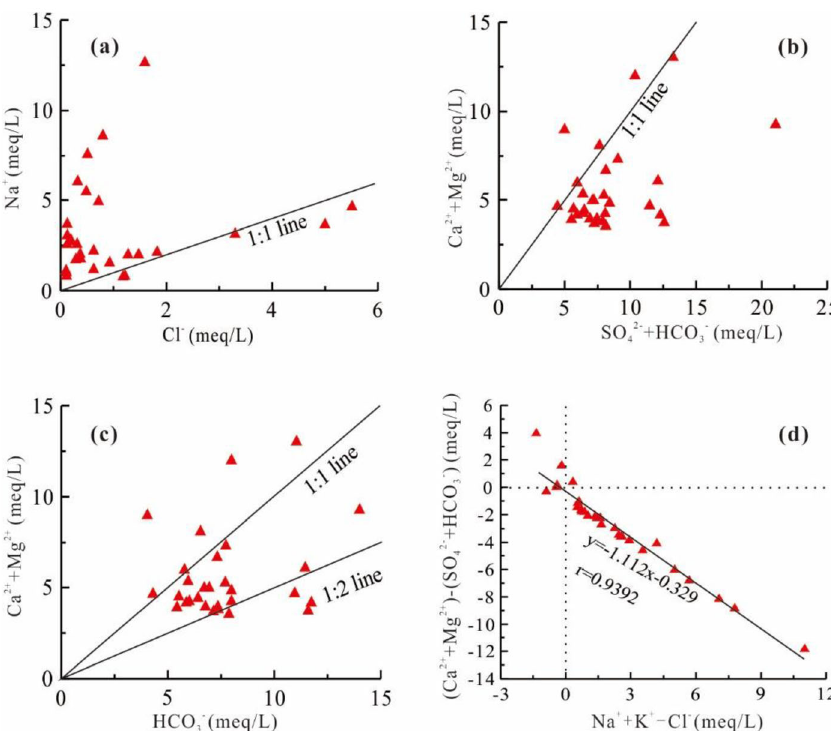
Fig. 6 Proportion diagrams of major ionic concentrations in the groundwater samples. a Na ? versus Cl - , b Ca 2 ? ? Mg 2 ? versus SO 42 -